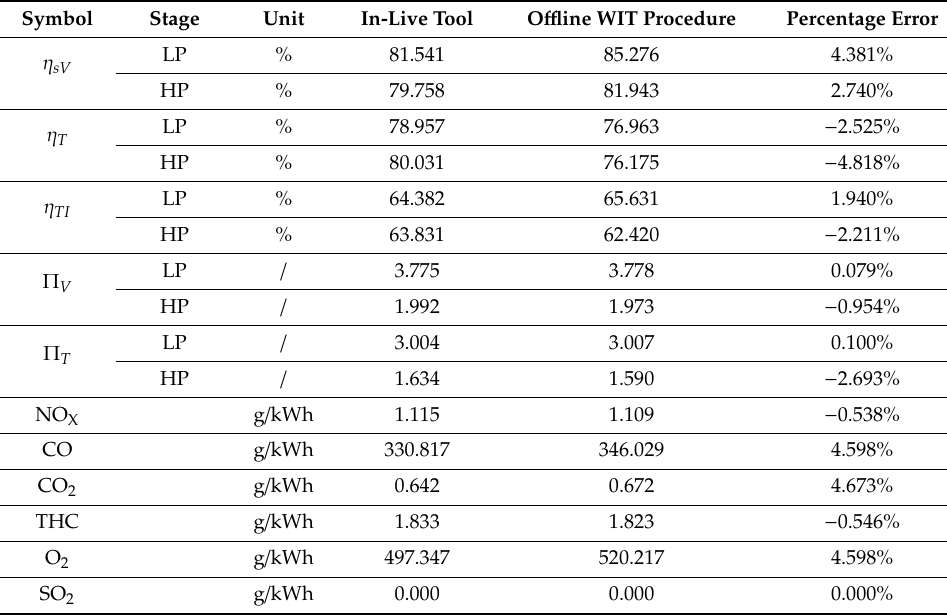
Table 7. Comparison between the output values–Air Nozzle method results.